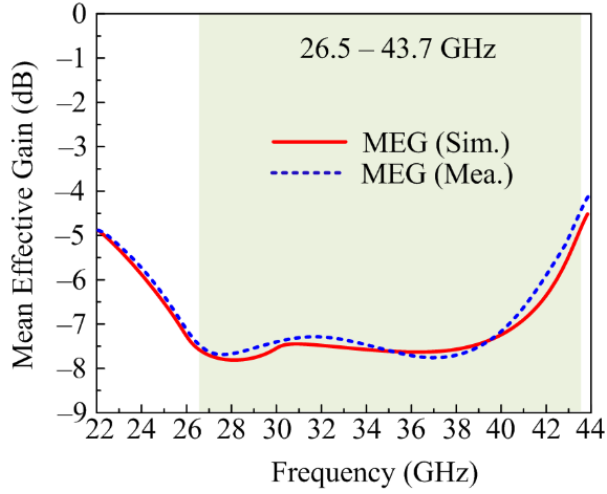
Figure 17. MEG of the proposed MIMO antenna.